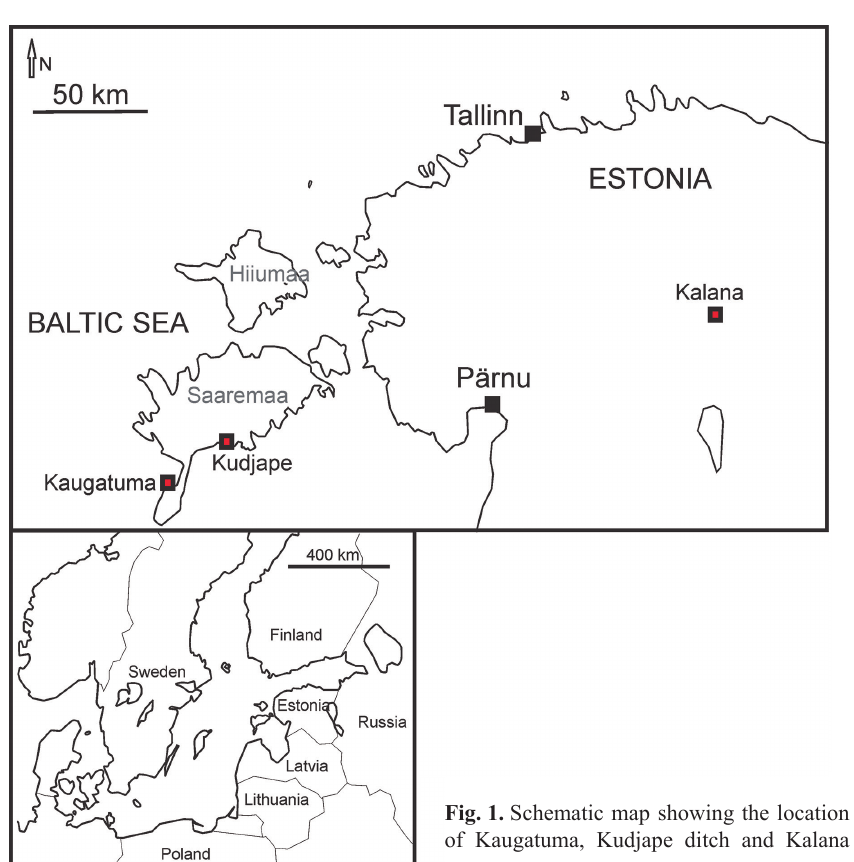
Fig. 1. Schematic map showing the location of Kaugatuma, Kudjape ditch and Kalana